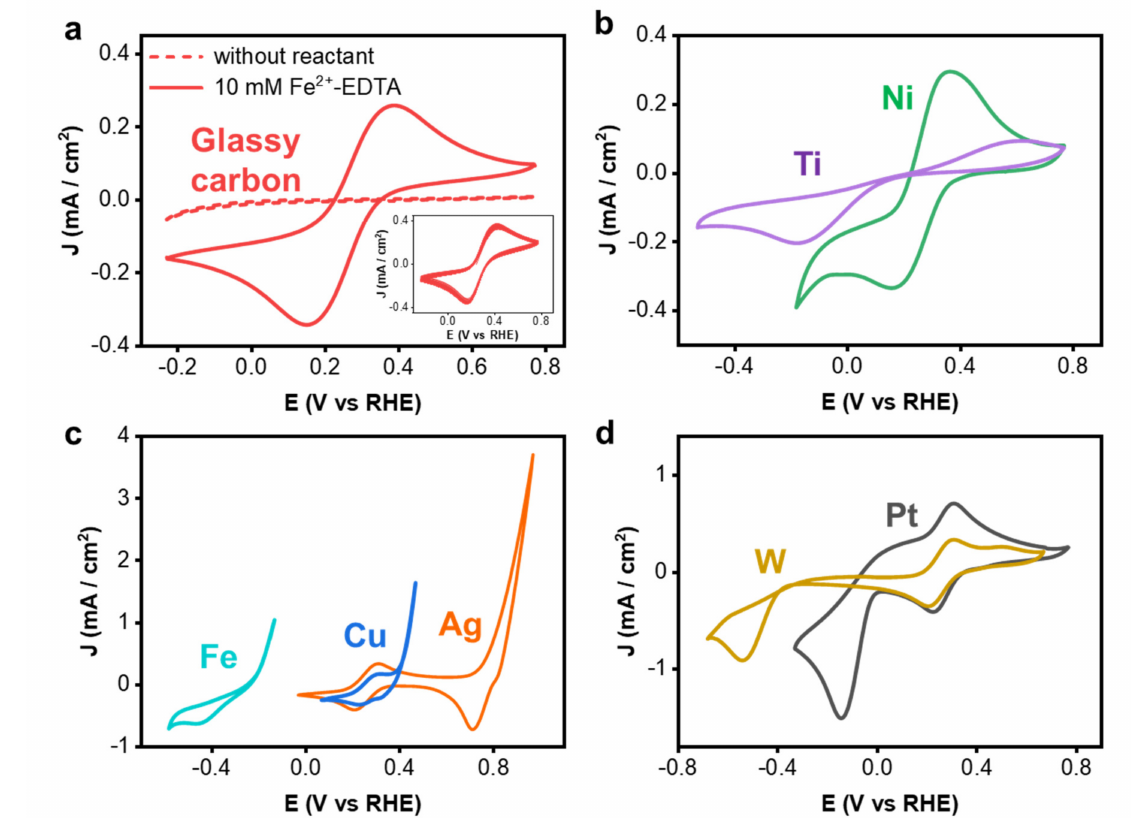
Figure 1. Electrochemical redox property of 10 mM Fe 2+ -EDTA complex in a 0.1 M Na 2 SO 4 aqueous solution (pH 2.7). The cyclic voltammetry curves were obtained with ( a ) glassy carbon plate, ( b ) Ni and Ti foil, ( c ) Fe, Ag, and Cu foil, and ( d ) Pt and W foil electrodes with a scan rate of 10 mV s − 1 . The dotted line in ( a ) is the CV curve of Na 2 SO 4 solution by using glassy carbon plate before mixing Fe 2+ -EDTA. The inset of ( a ) is the CV curve of Fe 2+ -EDTA solution with the glassy carbon plate for 200